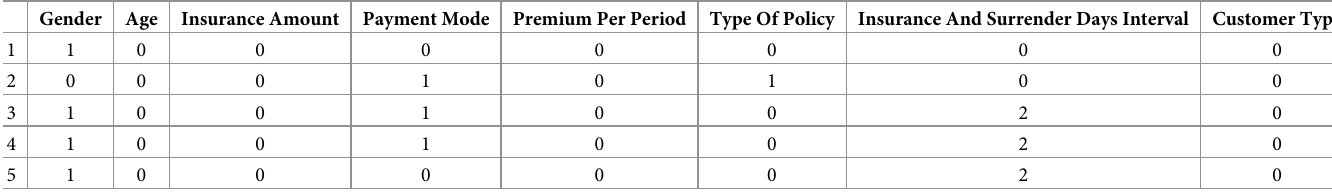
Table 2. Preprocessing data